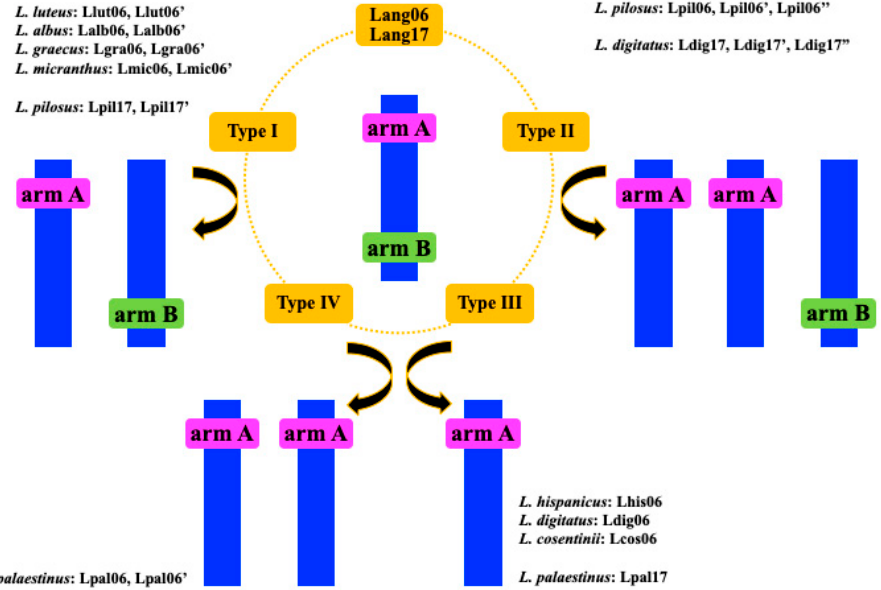
Figure 6. Scheme of the structural rearrangements within Lang06 and Lang17 of L. angustifolius and the related lupins. The pink and green rectangles correspond to arm A and arm B of both of the Lang06 and Lang17 chromosomes in related lupins.